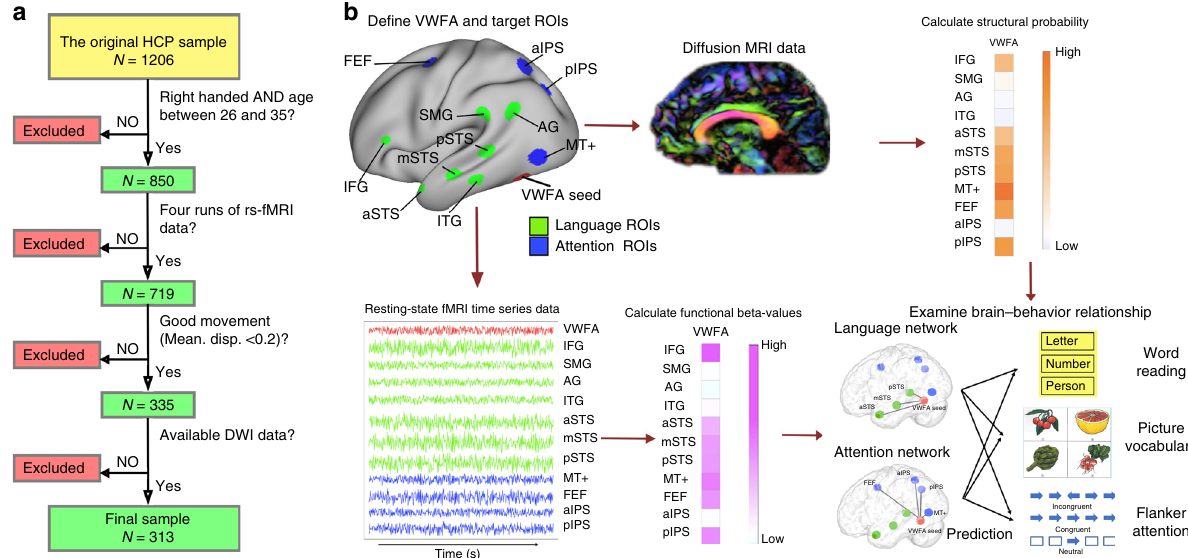
Fig. 1 Participant selection and analysis pipelines. a Key steps in selection of right-handed participants from the original HCP sample ( N = 1206) to achieve a fi nal sample size of N = 313; and b Data analysis pipeline for computing structural and functional connectivity measures and examining brain- behavior relationships (Exemplar image of picture vocabulary was adapted from Pichette et al. 30